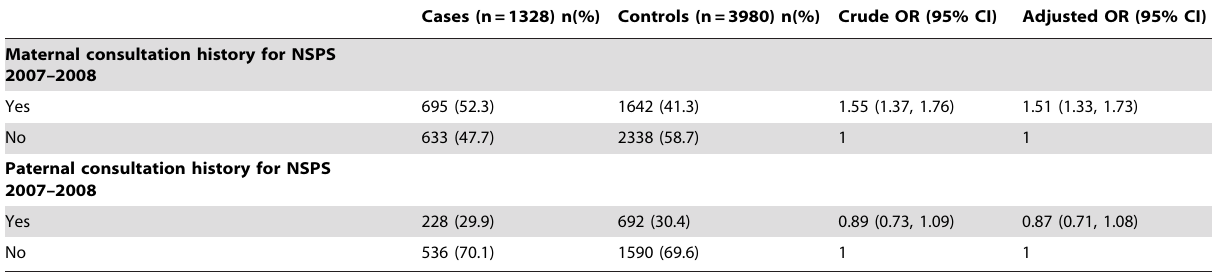
Table 3. Associations between consultations for NSPS in either parant and children.